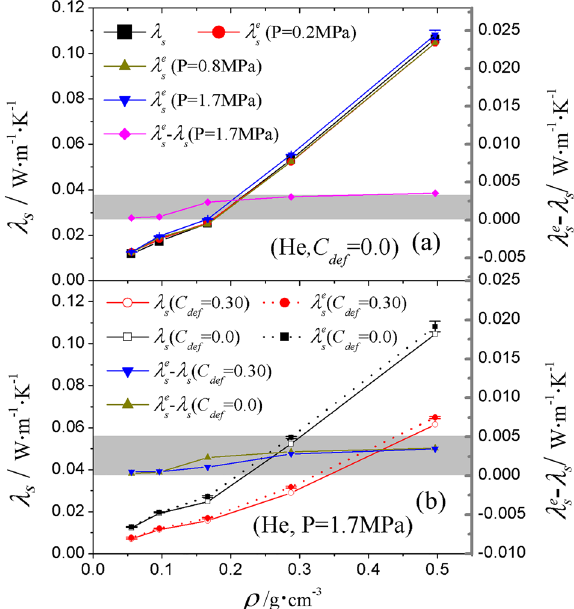
Figure 8. Effective solid thermal conductivity (cid:31) e s in He atmosphere as a function of ( a ) gas pressure and ( b ) defect concentration C def . For clarity, the results for perfect ( C def = 0) and defective structures were aligned to the same ρ